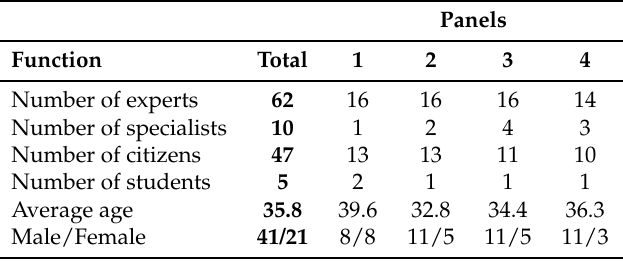
Table 1. Overview of the experts who participated in the elicitation in September 2019. Panels Function Total 1 2 3 4 Number of experts 62 16 16 16 14 Number of specialists 10 1 2 4 3 Number of citizens 47